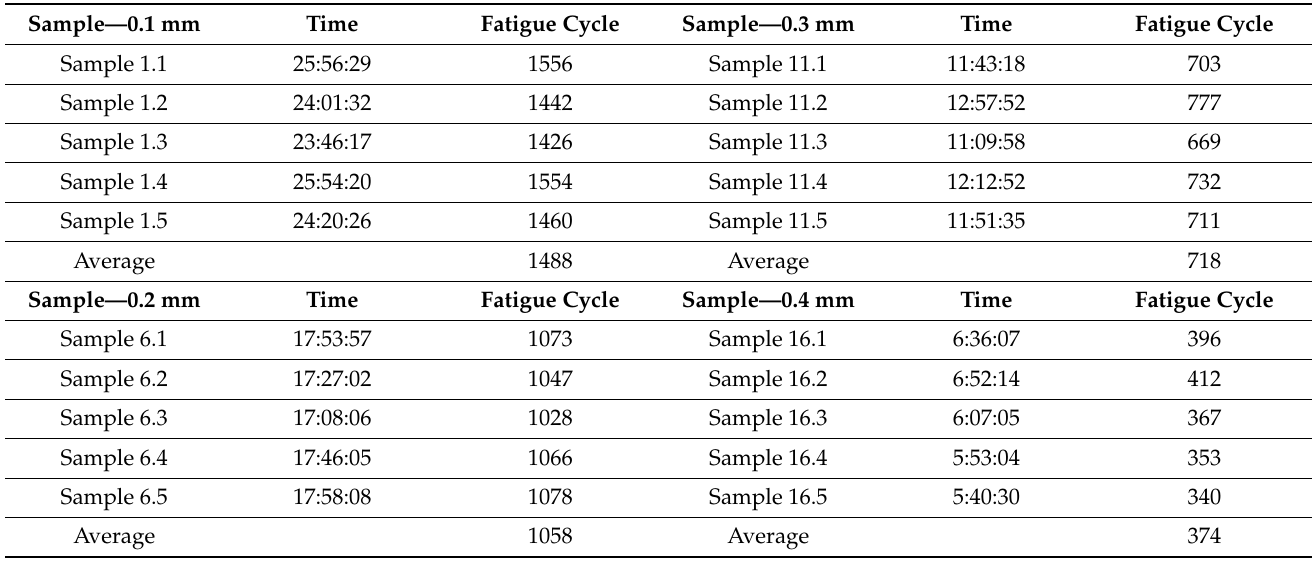
Table 2. The fatigue cycle of PP samples with different amplitudes and 1 Hz frequency.